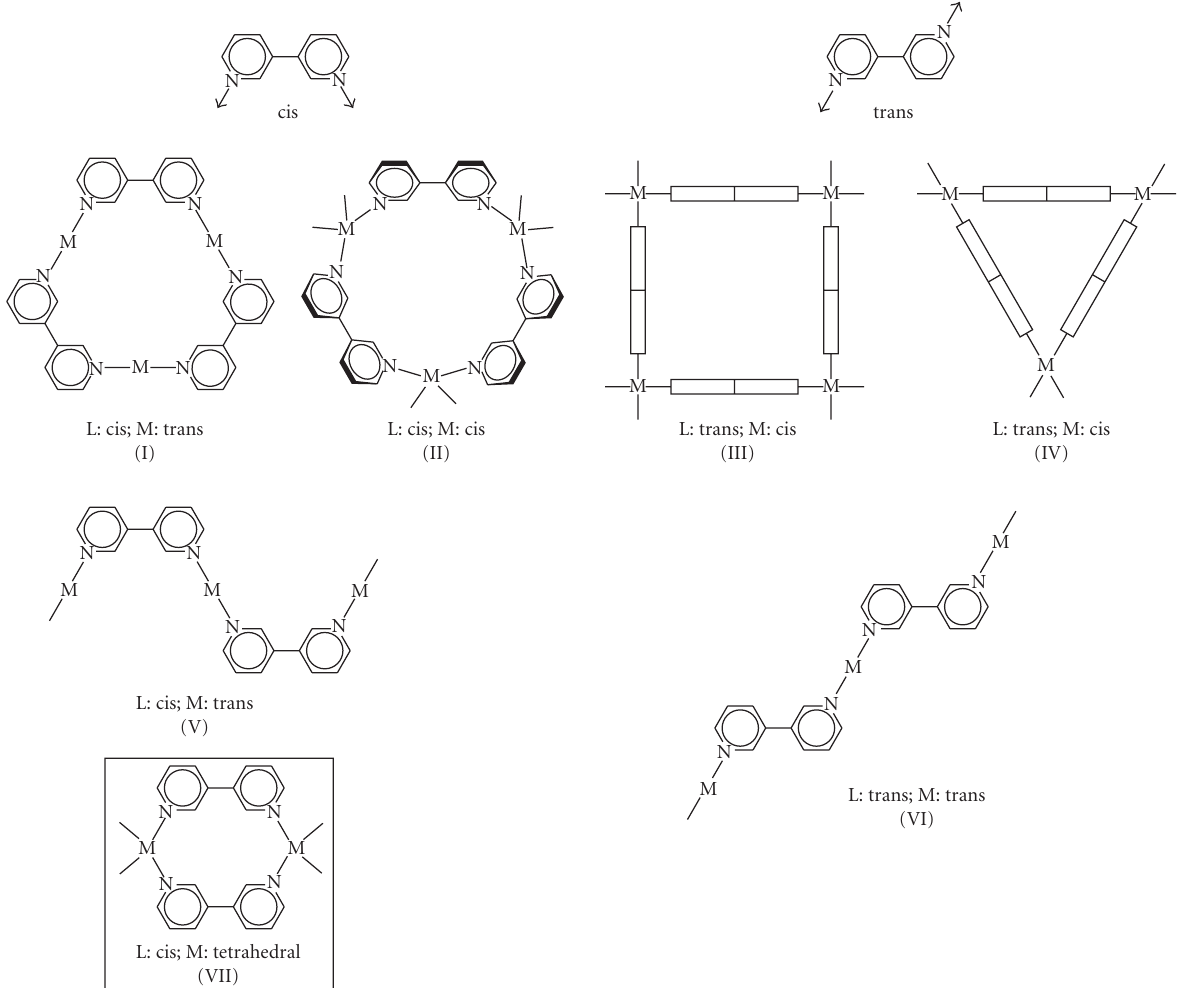
Figure 1: Feasible discrete (I–IV) and polymeric (V, VI) structures of 3,3 (cid:2) -bpy metal complexes, and novel dinuclear complex (VII) observed in the Hg II complex 2